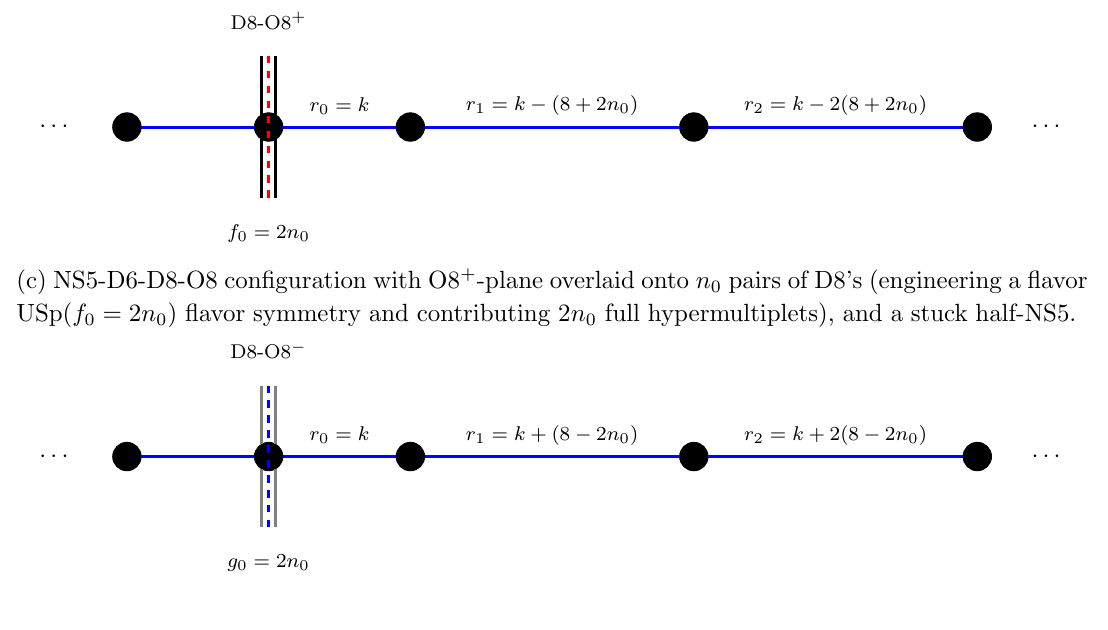
(d) NS5-D6-D8-O8 con(cid:12)guration with O8 (cid:0) -plane overlaid onto n 0 pairs of D8’s (engineering a (cid:13)avor SO( g 0 = 2 n 0 ) (cid:13)avor symmetry and contributing 2 n 0 full hypermultiplets), and a stuck half-NS5. Figure 3. Possible NS5-D6-D8-O8 brane con(cid:12)gurations without O6-planes or extra D8-branes.